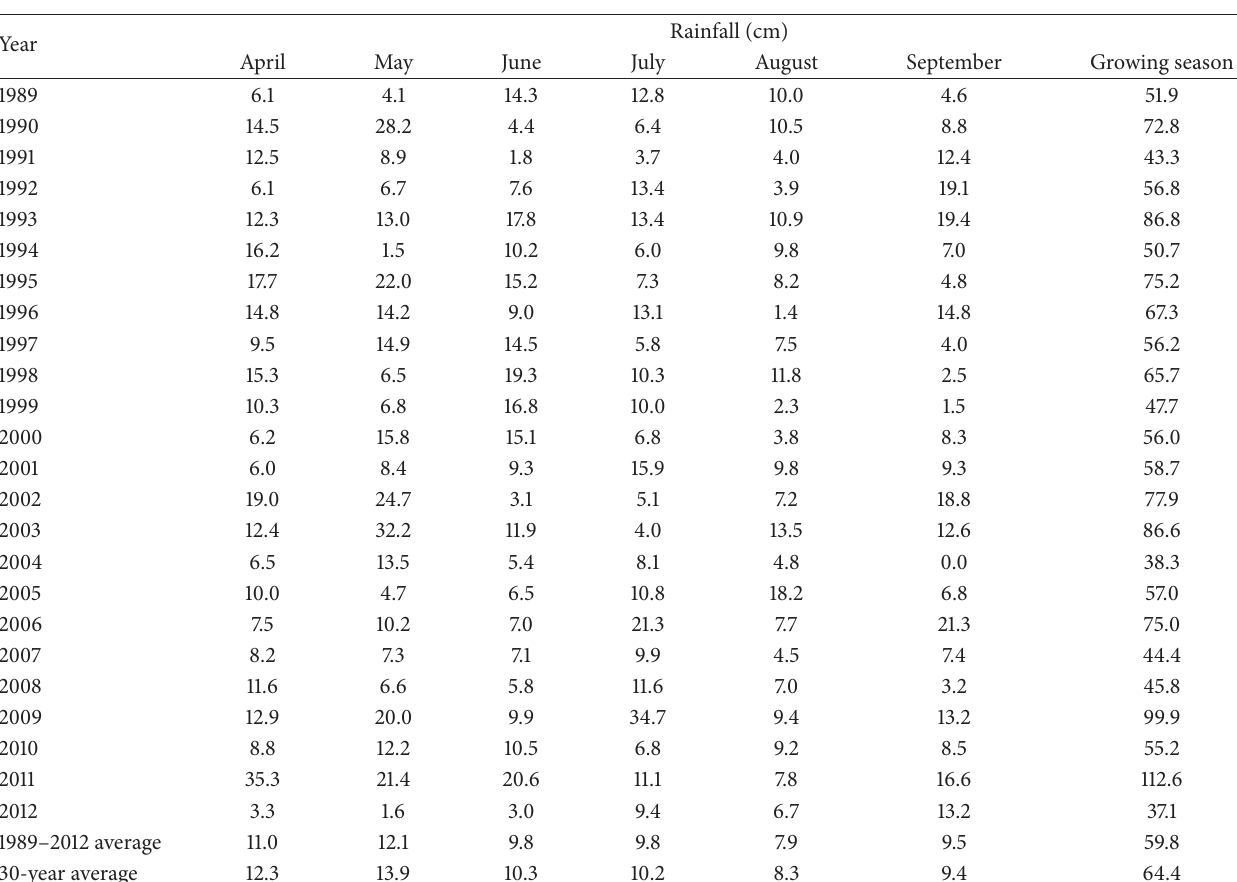
Table 2: Rainfall data for 1989–2012 growing season at Dixon Springs in Southern